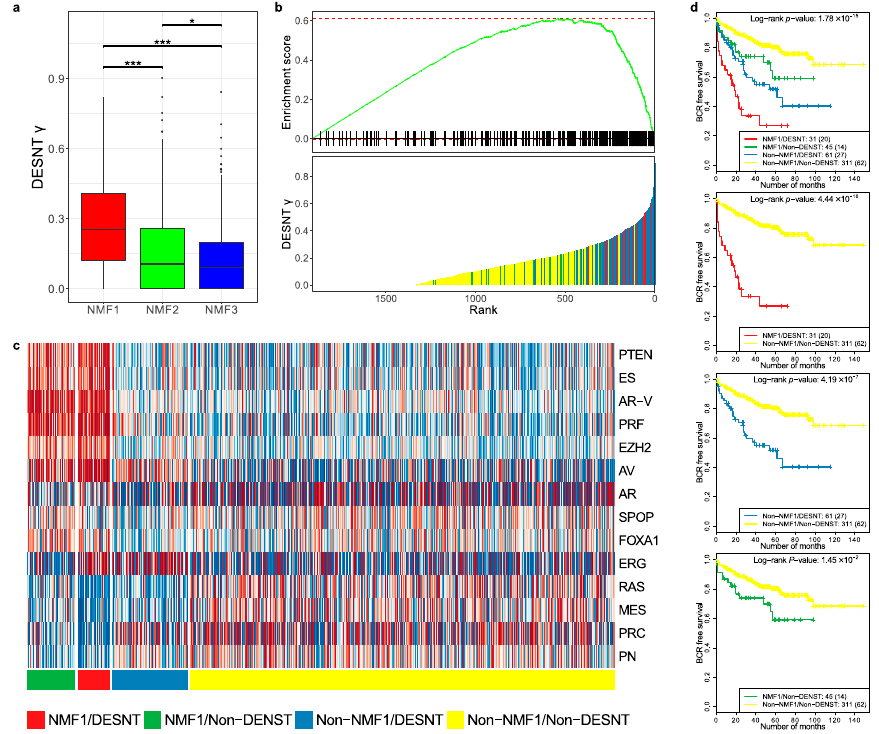
Figure 4. Comparison of DESNT and non-negative matrix classifications. ( a ) Distribution of DESNT γ for cancers assigned to NMF1, NMF2 and NMF3. ( b ) Gene Set Enrichment Analysis. Cancers were ranked according to DESNT γ (Lower Panel). The enrichment for cancers assigned to the NMF1 high-risk group (vertical lines) is shown (Upper Panel). ( c ) Pathway activation profiles for each cancer arranged according to DESNT and NMF1 subgroup status. The key is shown at the bottom of the figure. ( d ) Kaplan–Meir plots for the different cancer categories. The outcome used is time to biochemical recurrence post prostatectomy. * ≤ 0.05; ** ≤ 0.01; *** ≤ 0.001.